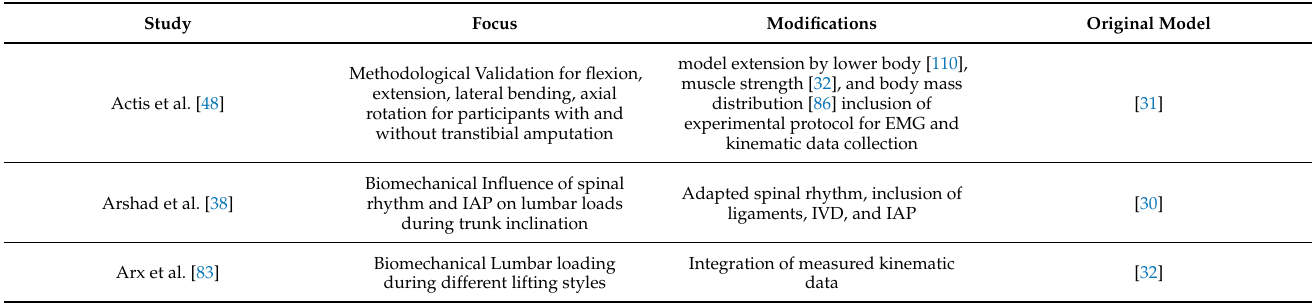
Table 2. Overview of representative studies using available original models to address methodologi- cal or biomechanical research